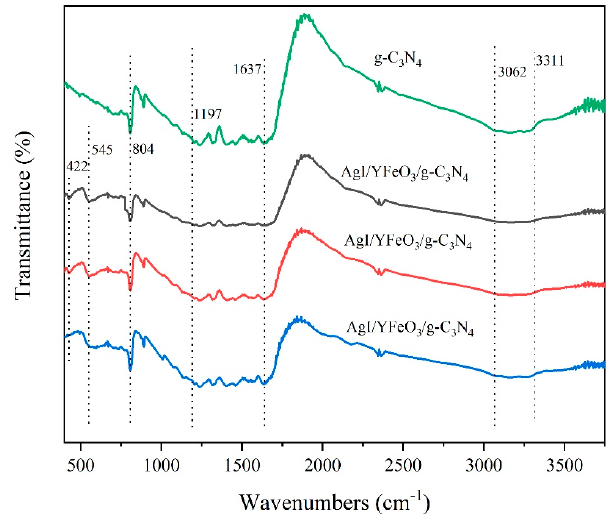
Figure 2. FT-IR absorbance spectra of obtained samples.